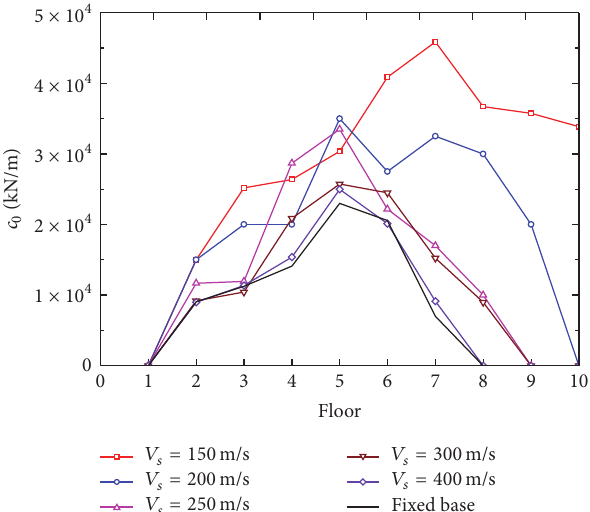
Figure 13: The comparison of optimal placement of VEDs among different soil types (10-story structure).